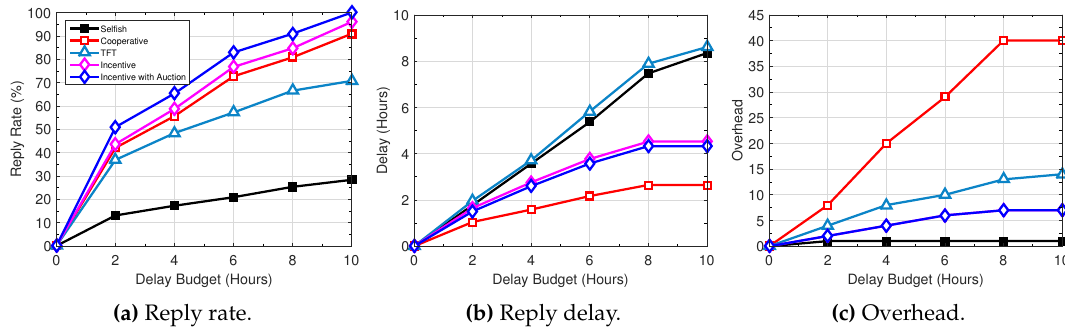
Figure 9. Performance trend with increasing delay